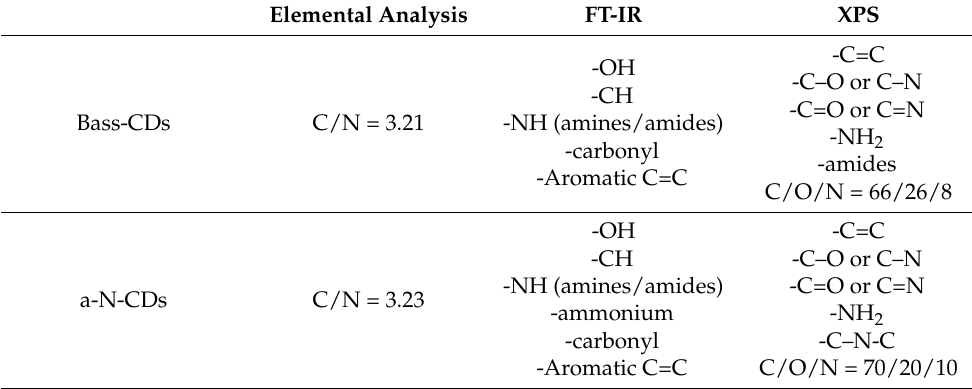
Table 2. Comparison of morphology, composition and surface properties of bass-CDs and